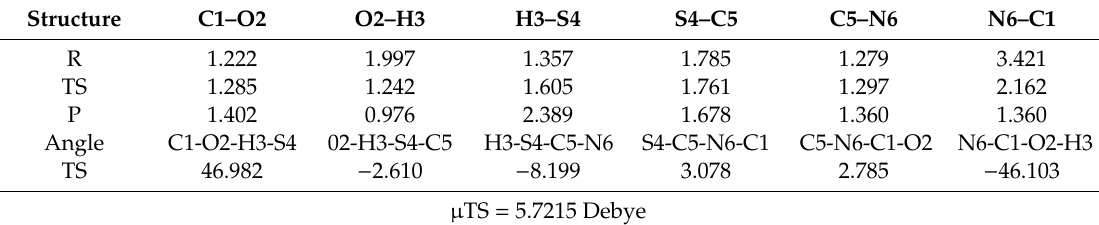
Table 3. Structural parameters for R, TS, and P, involved in the Biginelli reaction, from the B3LYP/6- 31++G(2d,p) level of theory for 4-hydroxybenzaldehyde.